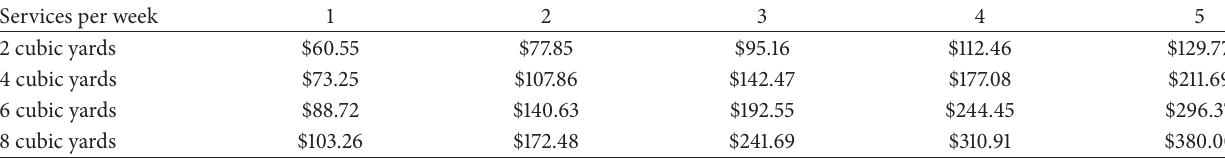
Table 1: Monthly dumpster service cost based on capacity and frequency of service.